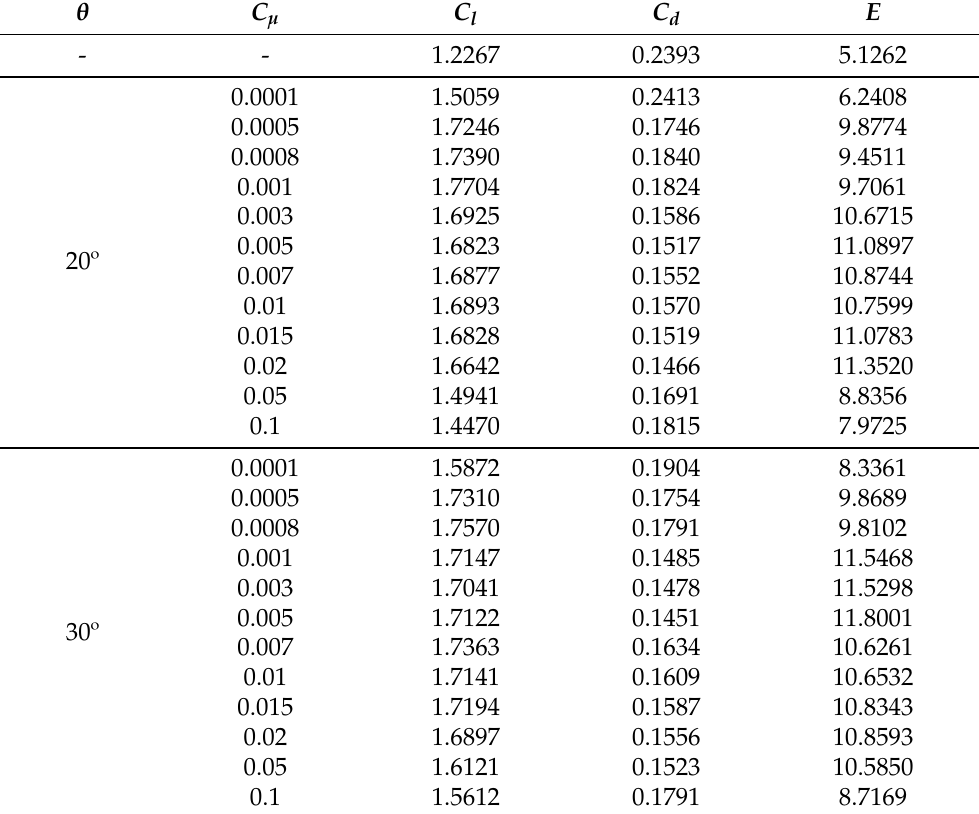
Table A1. AFC results comparison at different jet injection angles θ and momentum coefficients C µ . θ C µ C l C